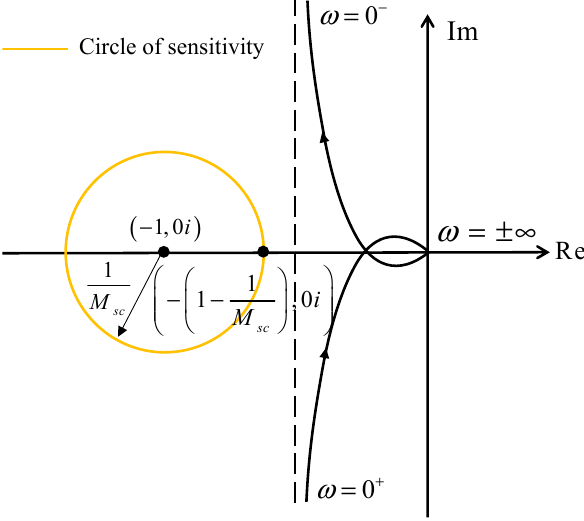
Figure 2. Schematic diagram of the first-order linear ADRC.